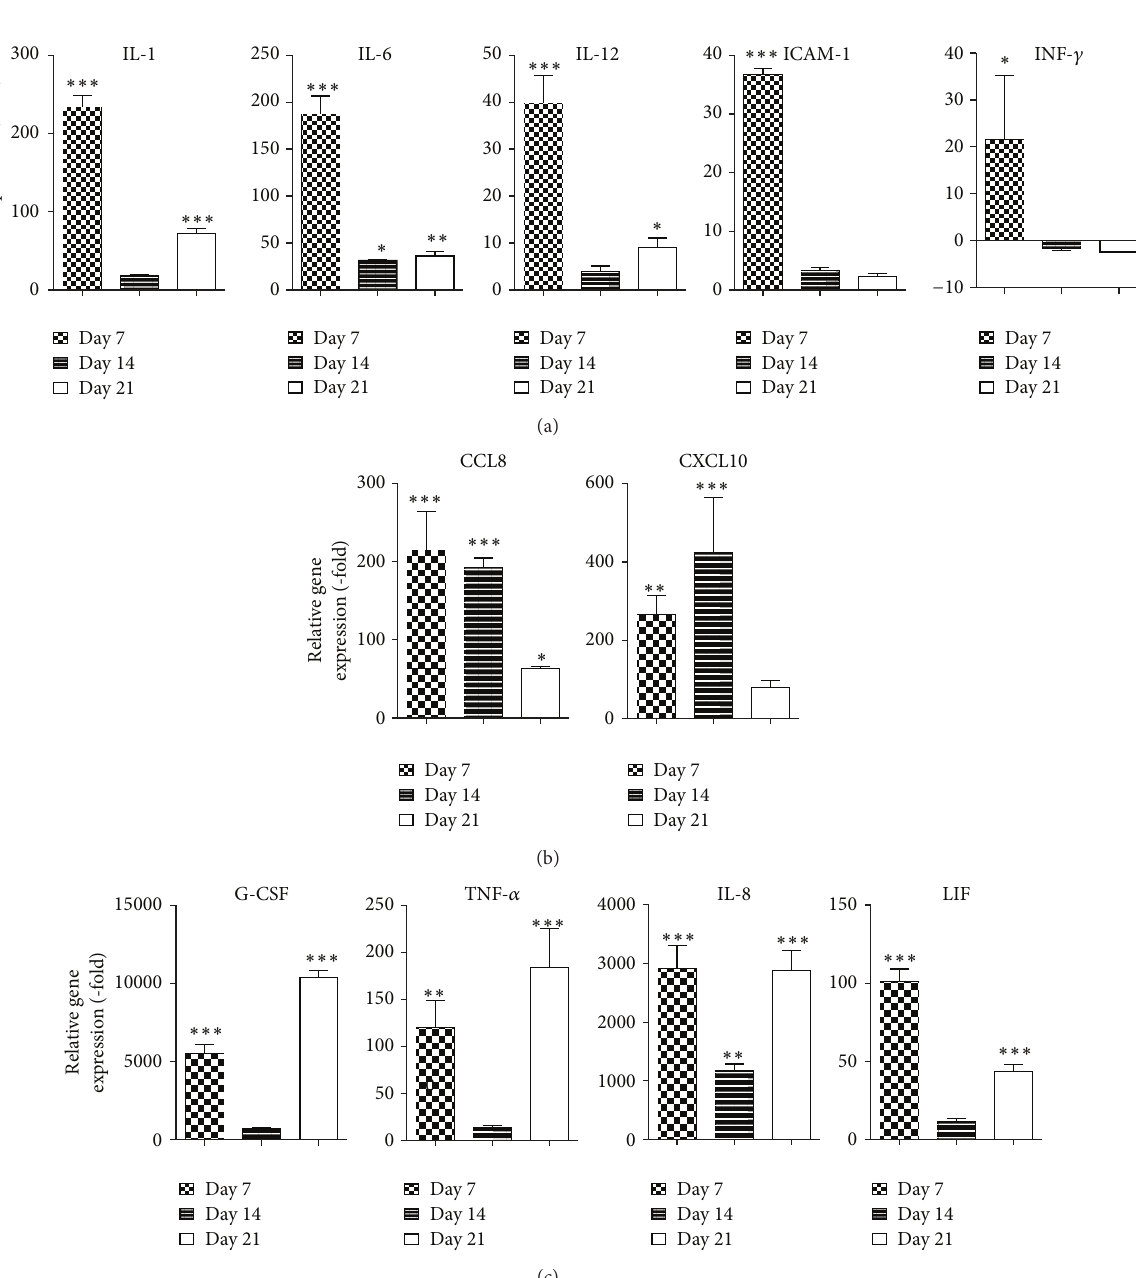
Dependent. ASCs at passage 2 were expanded in CCM until confluent and cultured in ODM. At 7, 14, and 21 days of culture, cells were harvested and the mRNA expression of pro- and anti-inflammatory cytokines was assessed in com- parison to undifferentiated ASCs. ASCs induced with ODM demonstrated an increase in the expression of proinflamma- tory cytokines interleukin-1 (IL-1; 223.3-fold, 𝑃 < 0.001 ), interleukin-6 (IL-6; 187.3-fold, 𝑃 < 0.001 ), interleukin-12 (IL- 12; 39.8-fold, 𝑃 < 0.001 ), intercellular adhesion molecule 1